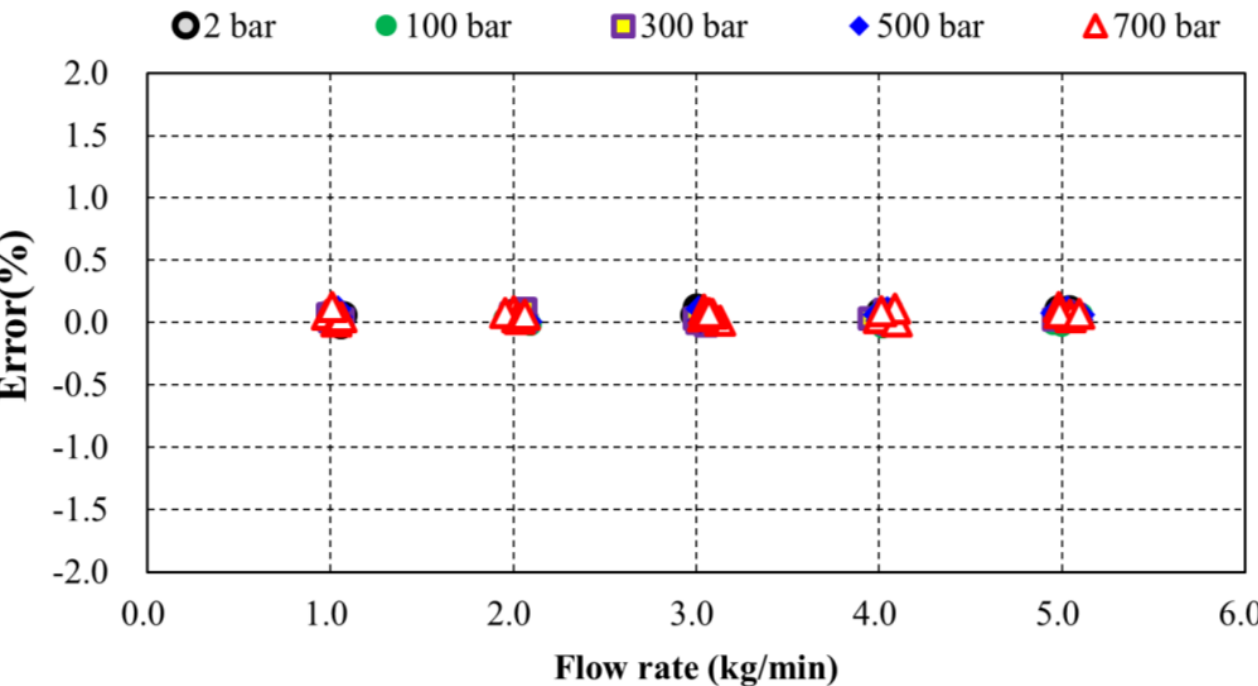
Figure 10. Measurement results of the Coriolis mass flowmeter at the inlet pressure condition from 2 bar to 700 bar.